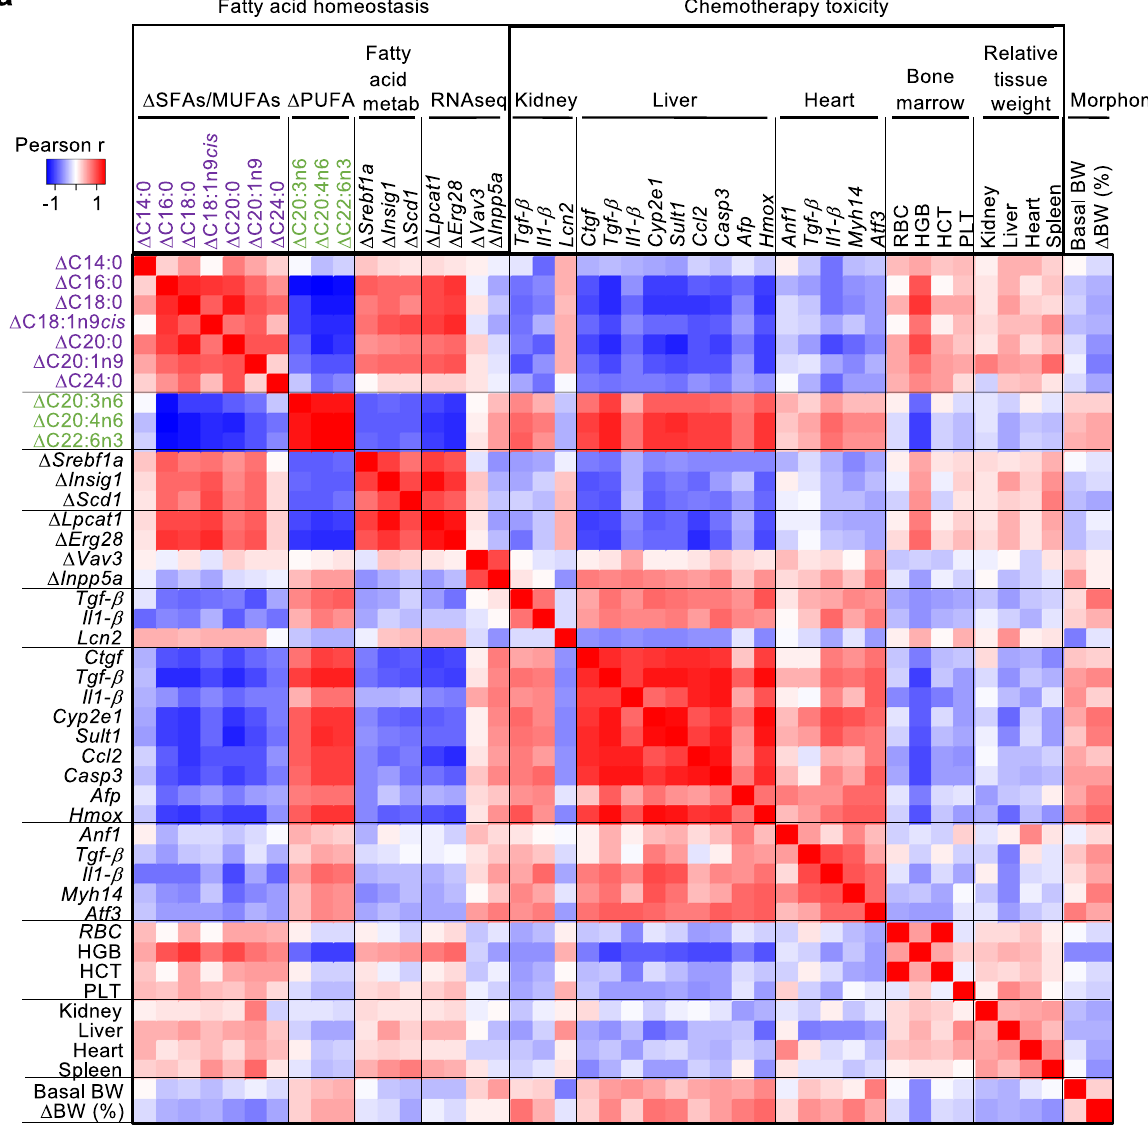
hemoglobin(HGB),hematocrit(HCT)andplateletcounts(PLT);andtissueweights relative to total body weight. At the right end of the graph, the morphometric parametersofbasal body weight (BW) and change inbodyweight with fasting in % ( Δ BW (%)) are also analyzed. These correlations were performed with n =26 mice. Source data are provided as a Source Data fi